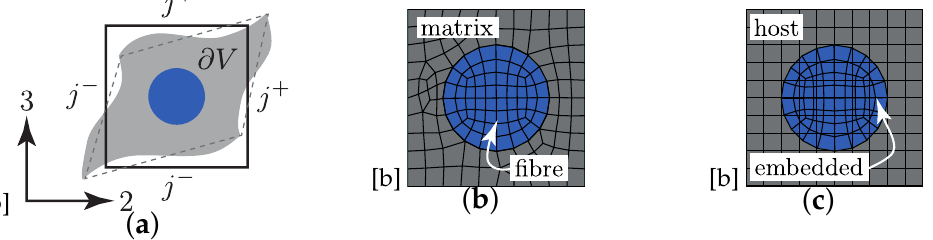
Figure 14. ( a ) Schematic illustration and notation of periodic boundary condition, ( b ) regular mesh and ( c ) embedded element mesh (exemplary for a fibre matrix